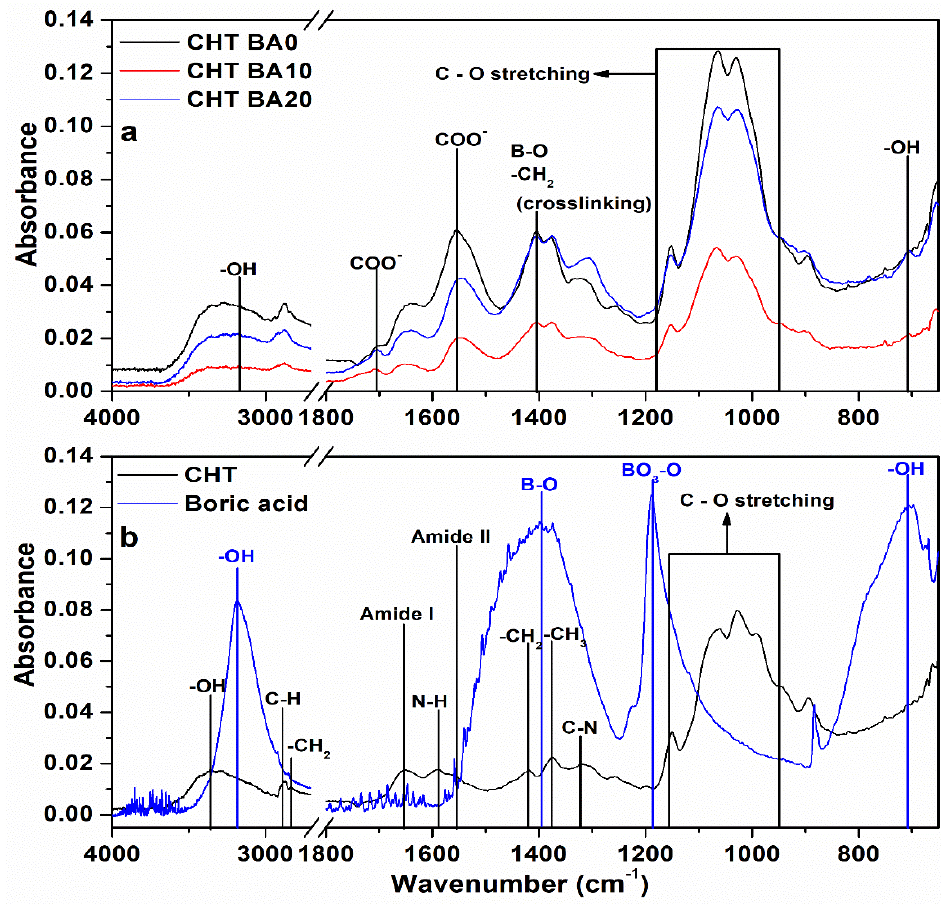
Figure 1. FTIR spectra of ( a ) boric acid–modified chitosan scaffolds and ( b ) pristine chitosan scaffolds and boric acid.